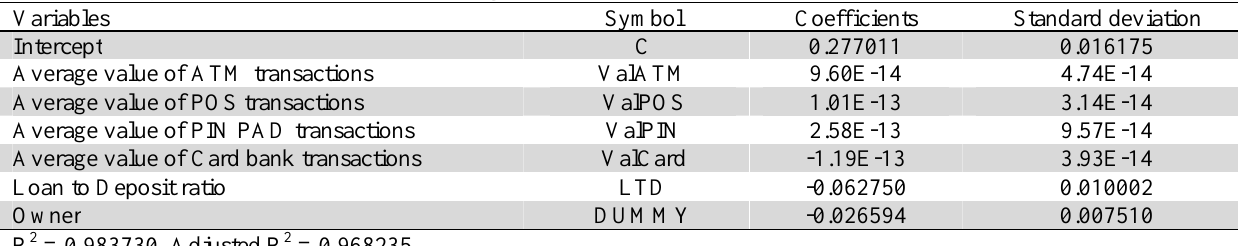
Relationship between electronic banking and LQTTA index